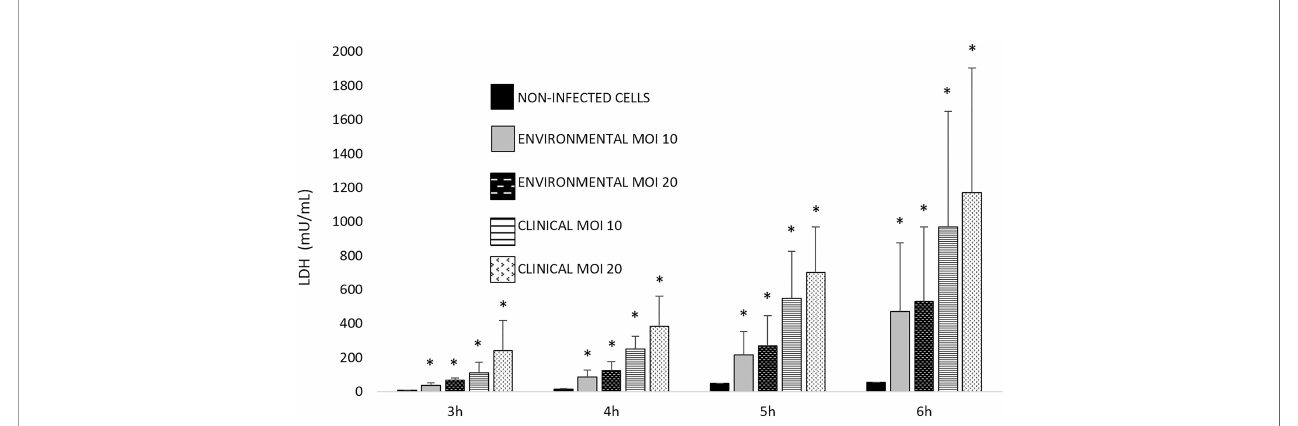
FIGURE 3 | Observed THP-1 cell damage induced by clinical and environmental strains of Aeromonas spp. at different exposure times and multiplicities of infection (MOIs). Asterisks indicate statistical signi fi cance *p